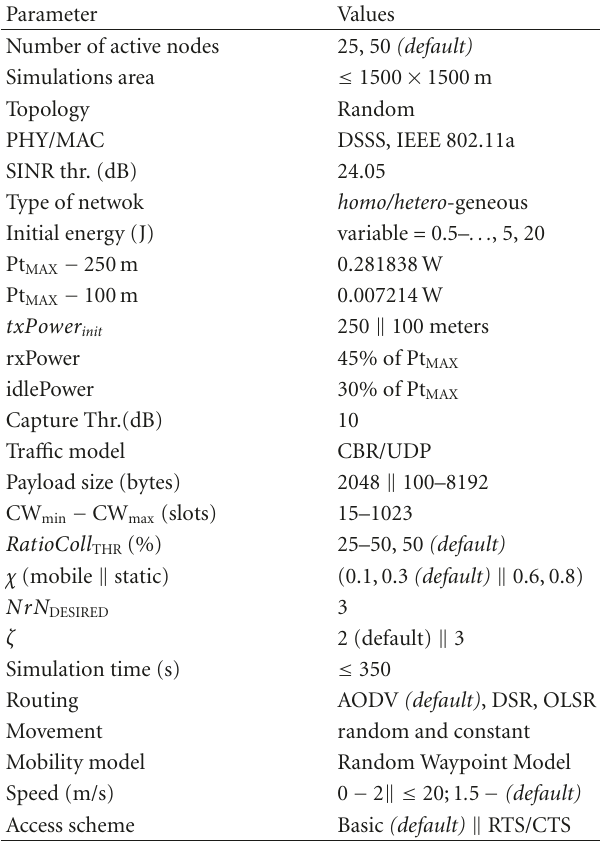
Table 1: Simulations parameters.